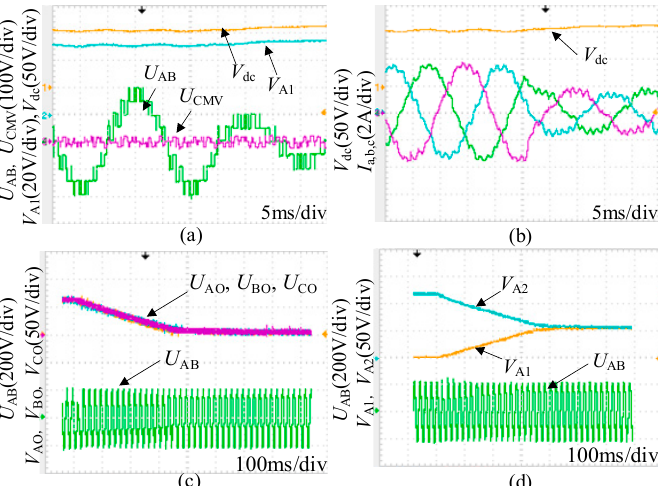
Figure 14. The pulse width modulations (PWMs) of phase A when m = 0.4 and m = 0.9. Energies 2019 , 12 , x FOR PEER REVIEW 12 of 13 Figure 12. The pulse width modulations (PWMs) of phase A when m = 0.4 and m = 0.9.